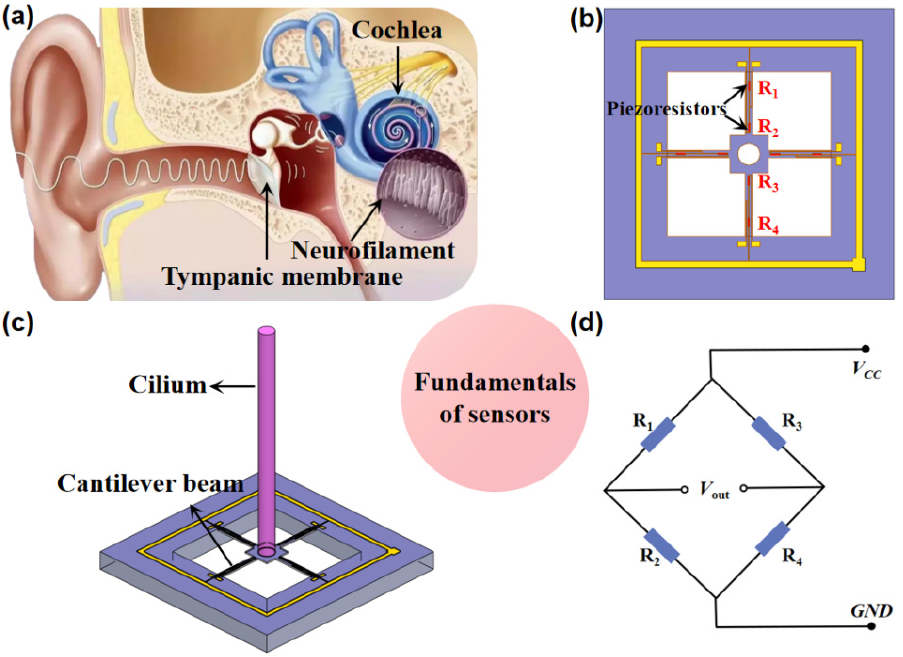
Figure 1. Principle of bionic microsensors. ( a ) Human ear’s sensory organ structure; ( b ) analysis diagram of microstructure; ( c ) microstructure of bionics; ( d ) Wheatstone circuit diagram.